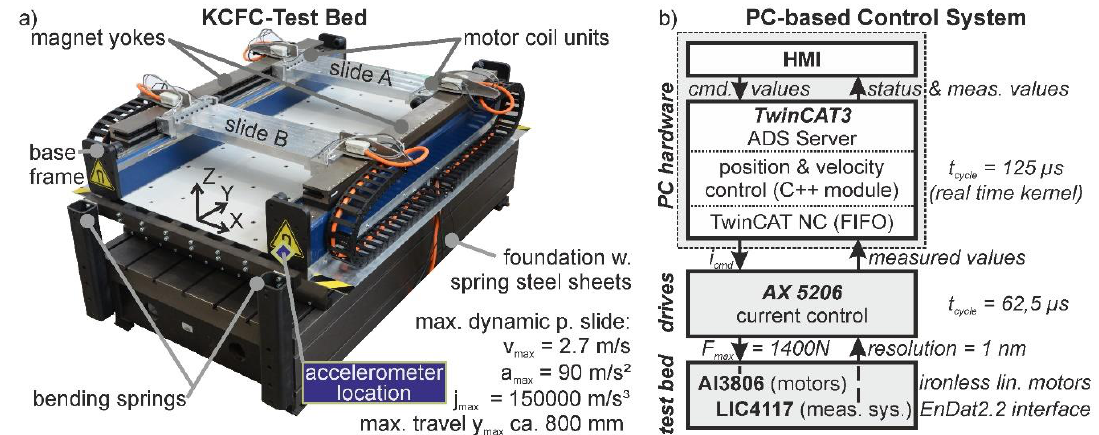
Figure 2. Mechanical design ( a ) and control system ( b ) of the 1D-KCFC test bed [14].